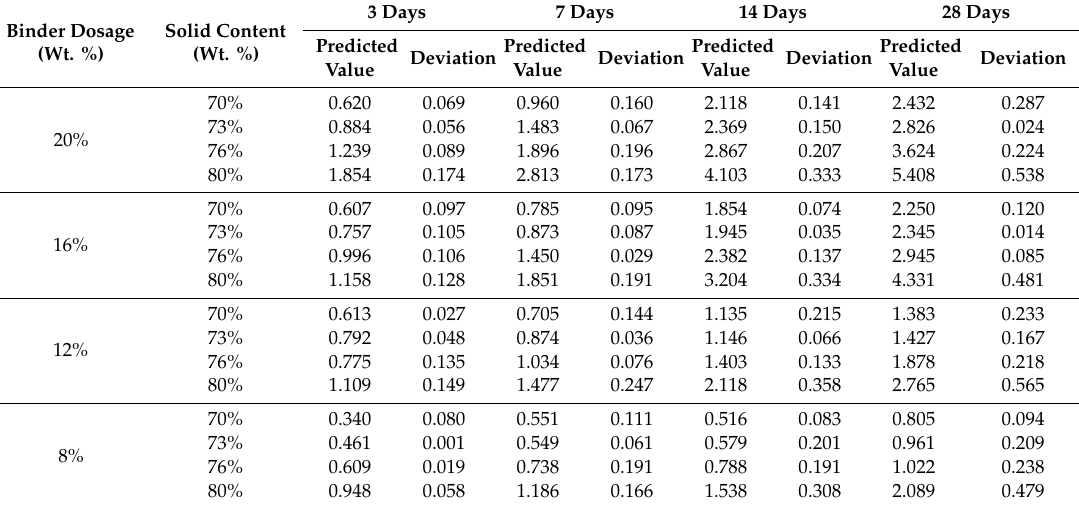
Table 8. The predicted value and deviation of AAS-CPB